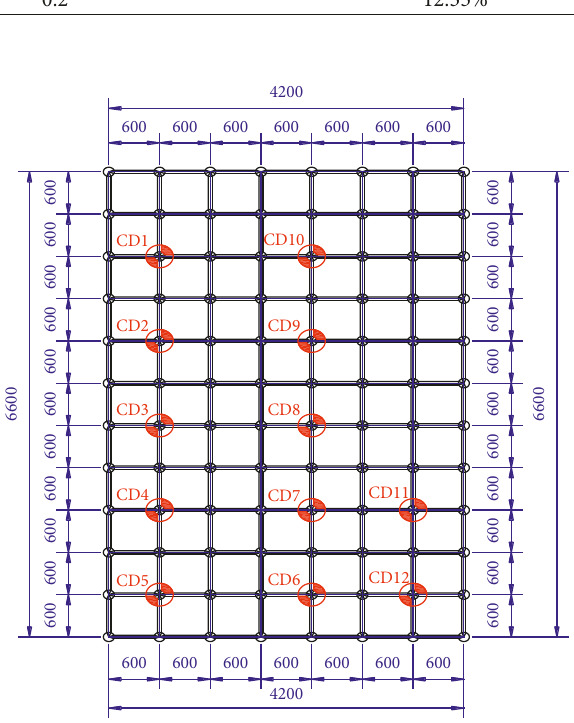
Figure 19: Diagram of vertical pole’s axial force measuring points.